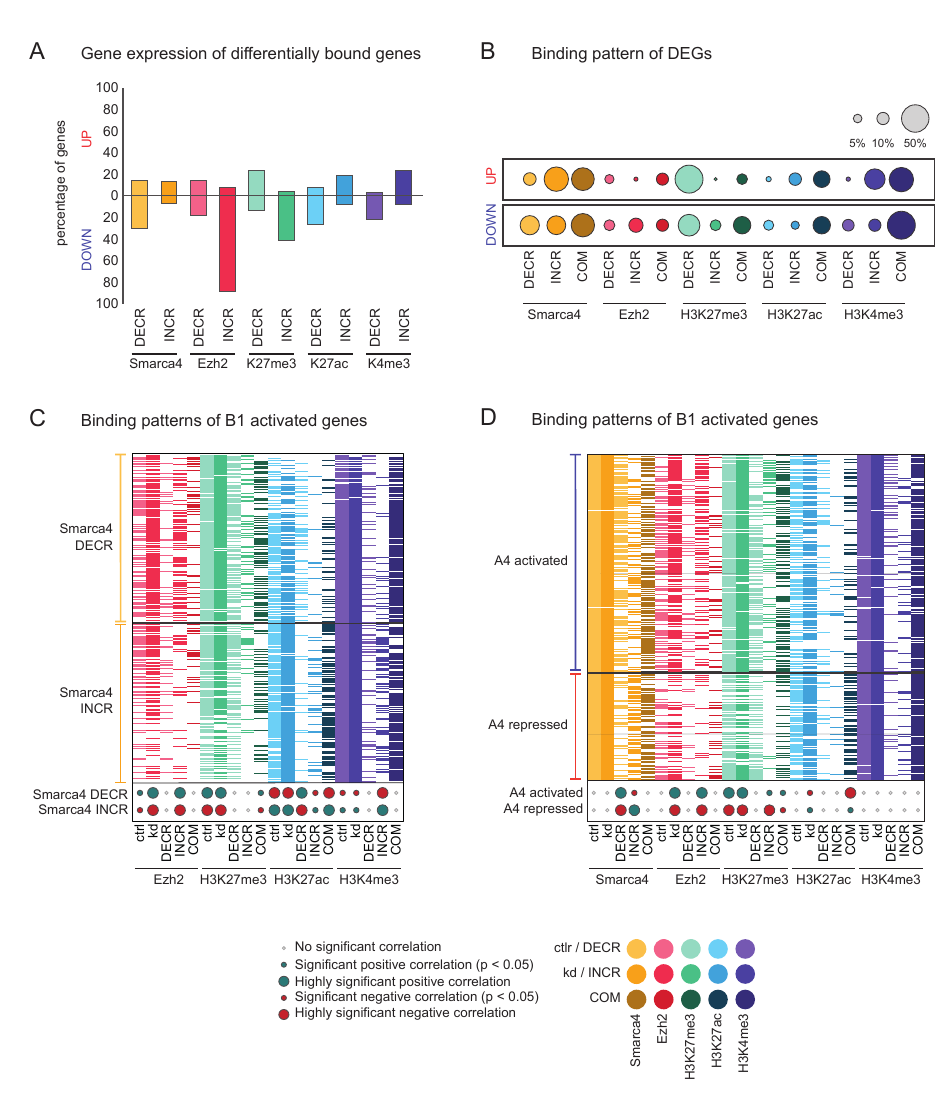
Figure 4. ChIP-seq defines two different groups of downregulated genes being separated by their antibody binding patterns ( A ) Bar chart displaying merged information of ChIP-seq and RNA-seq data. For analysis, all genes were included fulfilling two conditions: ( I ) DECREASE (DECR) or INCREASE (INCR) in binding of the respective antibody and ( II ) existing RNA-seq data (excluding genes with p value > 0.05 and abs. log2FC > 0.58). Relative amounts were calculated separately for each condition by dividing number of genes with differential binding of the respective antibody and up- (log2FC > 0.58) or down- (log2FC < − 0.58) regulation by all genes, fulfilling ( I ) and ( II ). For ( B ), these were divided by all upregulated or downregulated genes, respectively (independent of antibody binding). ( C ) Heatmap showing antibody binding patterns of genes fulfilling the following criteria: ( I ) downregulated after Smarcb1 kd (Smarcb1-activated) and ( II ) Smarca4 DECREASE or INCREASE. Depending on Smarca4 binding, two groups were formed whose antibody binding patterns were compared using permutation tests (results below the heatmap). Aquamarine circles represent a positive correlation (genes are more likely to be bound by the antibody of interest if they are in the tested group) while red circles represent a negative correlation (genes are less likely to be bound by the antibody of interest if they are in the tested group). For a more detailed explanation of significance levels, see Materials and Methods. ( D ) Heatmap displaying antibody binding patterns of genes ( I ) downregulated after Smarcb1 kd (=Smarcb1-activated) and ( II ) changed expression after Smarca4 kd (data obtained by Ho et al. [34]). Depending on expression after Smarca4 kd, two groups were formed whose antibody binding patterns were compared using permutation tests (results below the